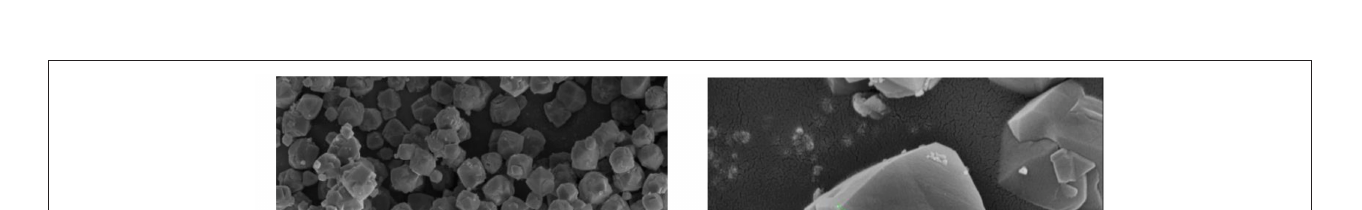
FIGURE 6 | XRD diffraction pattern of zeolite X samples.